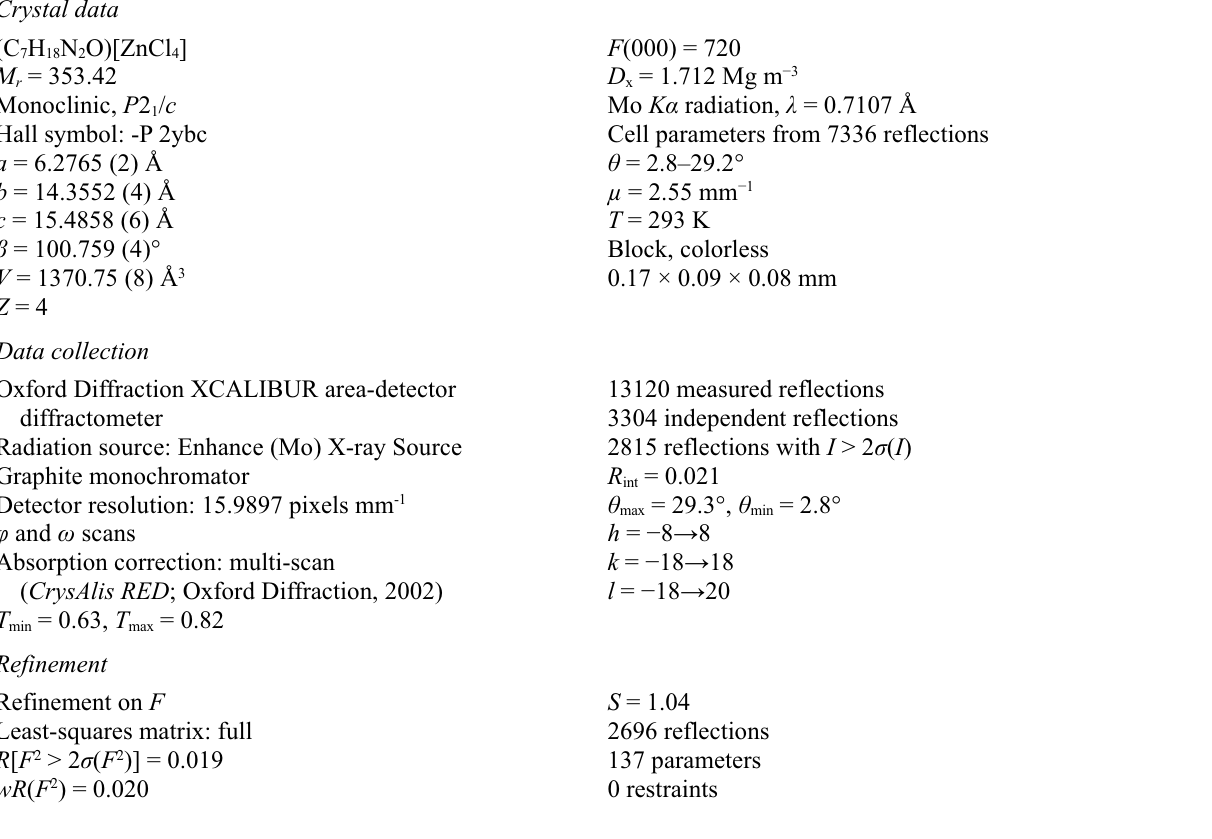
The packing of (I) viewed down the a axis showing layers at y = 1 / 4-(3-Ammoniopropyl)morpholin-4-ium